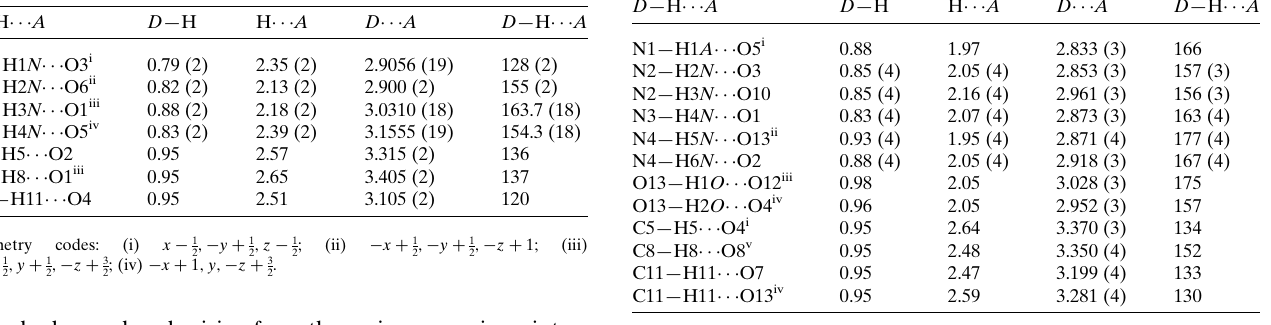
Table 2 Hydrogen-bond geometry (A˚ , (cid:3) ) for (II).